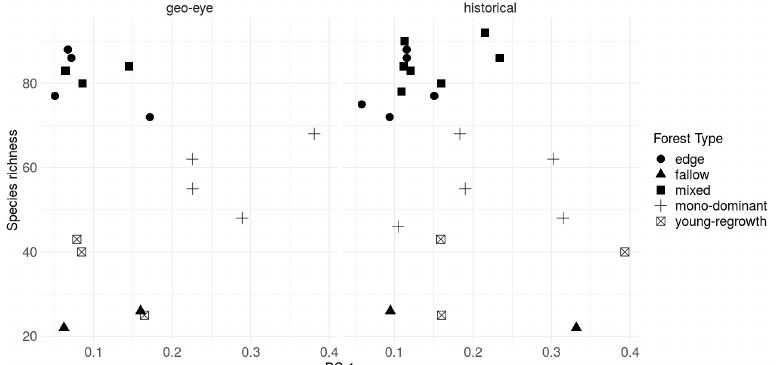
Figure A4. Scatterplot comparing Above Ground Carbon and the first principal component of the FOTO analysis for contemporary Geo-Eye ( left ) and the historical orthomosaic ( right ) data. Different forest types are plotted using closed circles, closed triangles, closed squares and this for fallow, mixed mon-dominant and young-regrowth forests, respectivelly